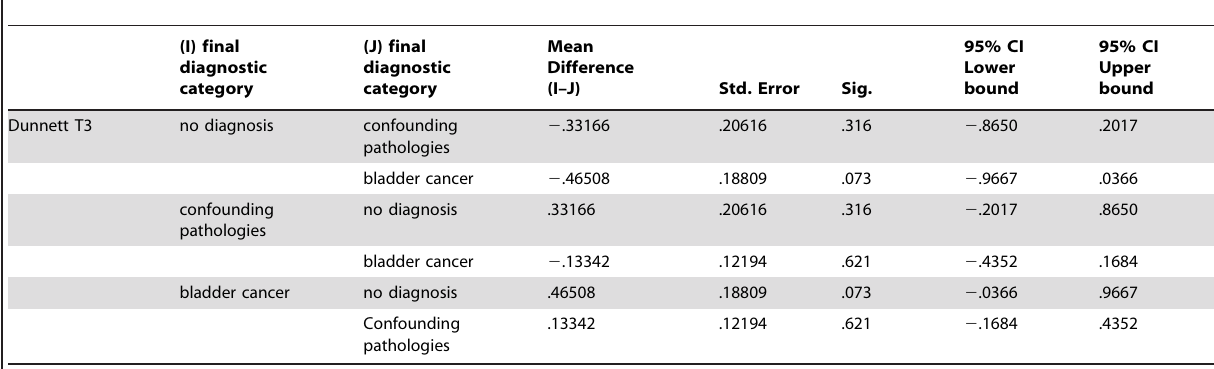
Table 1. Comparison of protein levels across final diagnostic